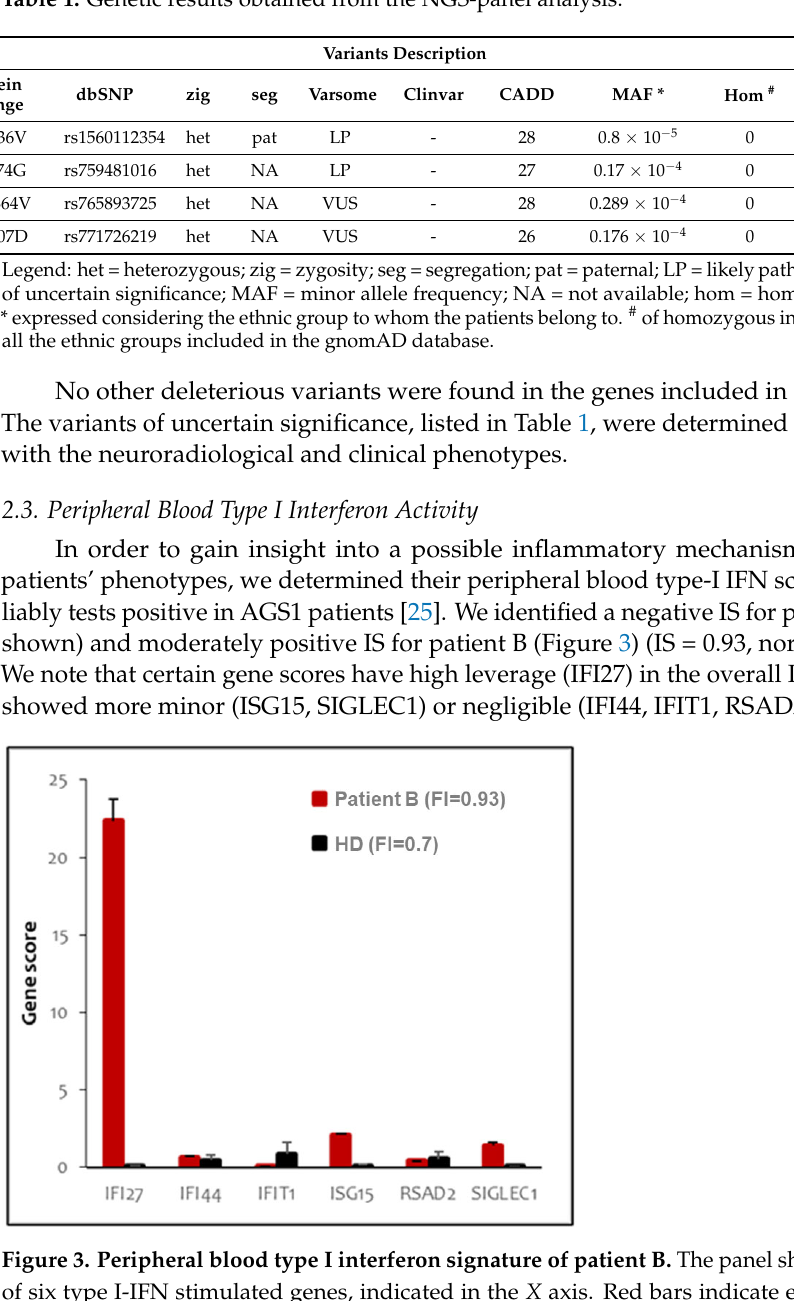
Table 1. Genetic results obtained from the NGS-panel analysis.